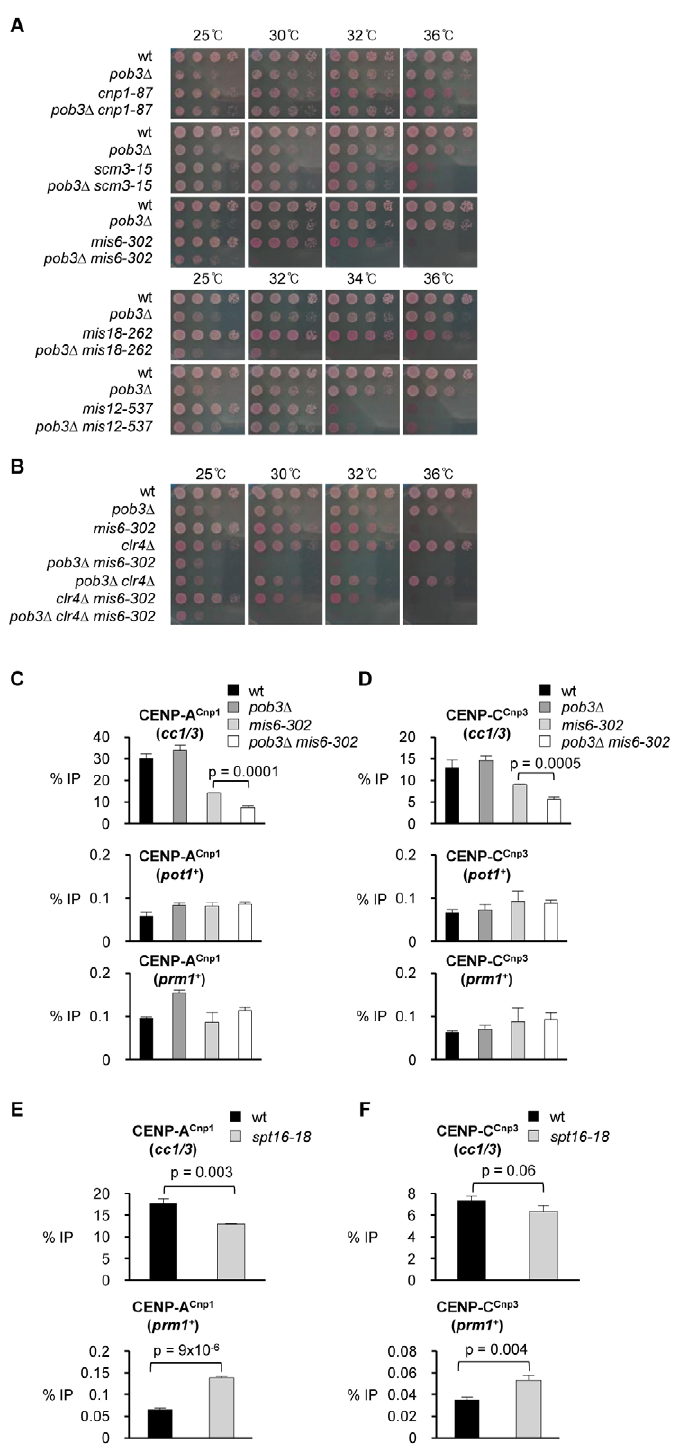
Figure 5. Pob3 genetically interacts with Mis6 and Mis18 and is required to maintain CENP-A Cnp1 at endogenous centromeres in mis6-302 cells. (A) Viability of cells bearing pob3 D combined with mutants affecting centromere function ( cnp1-87 , scm3-15 , mis6-302 and mis12-537 ) relative to wt cells and single mutants. Cells were spotted on plates containing Phloxine B at indicated temperatures. (B) Viability of wt and mutant cells bearing a combination of mutations in Pob3, Mis6 and Clr4 ( pob3 D , mis6-302 , clr4 D , pob3 D mis6-302 , pob3 D clr4 D , clr4 D mis6-302 and pob3 D clr4 D mis6-302 ). (C) ChIP analysis of CENP-A Cnp1 at endogenous centromeres ( cc1/3 ), pot1 + and prm1 + in the indicated strains. Cells were grown at 25 u C, shifted to 30 u C for 17 h after shift from 25 u C. (D) ChIP analysis of CENP-C Cnp3 in the same samples. (E) ChIP analysis of CENP-A Cnp1 levels at endogenous centromeres ( cc1/3 ) and prm1 + in wt and spt16-18 cells grown at 27 u C (semi-permissive for spt16-18 ) for 24 h. (F) ChIP analysis of CENP- C Cnp3 in the same samples. Enrichment is reported as % IP. Error bars indicate S.D. from 3 biological replicates.